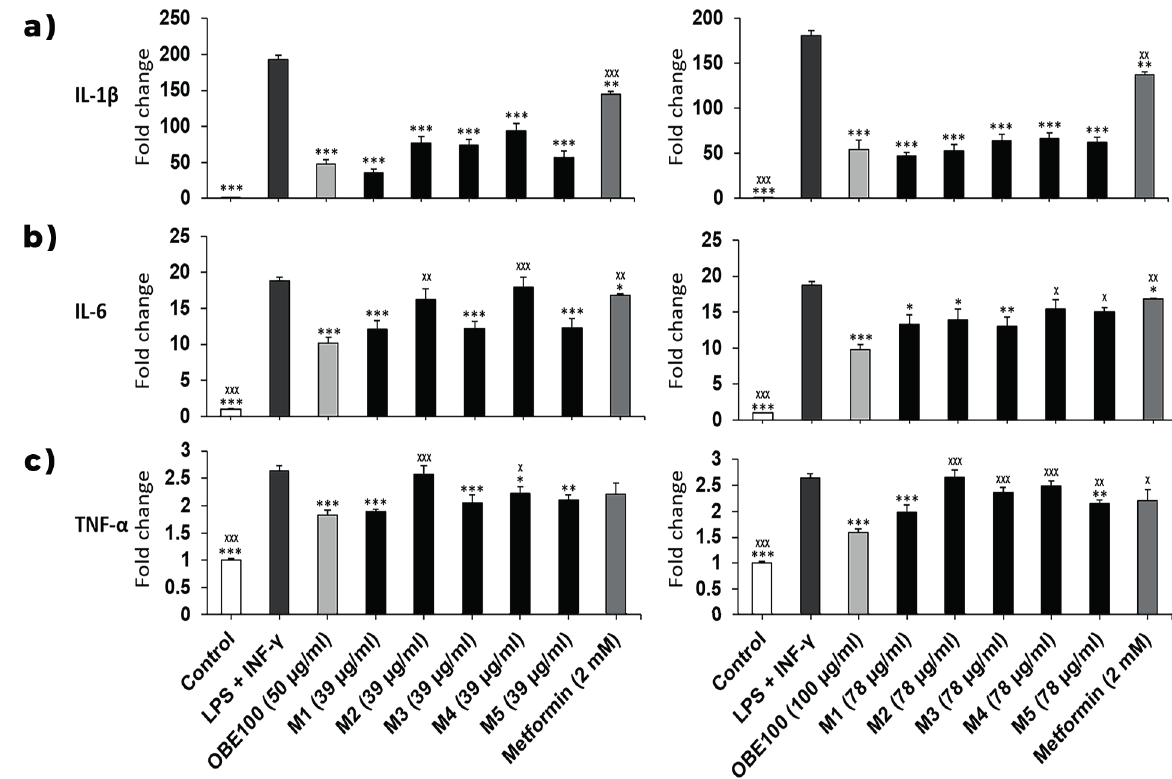
Figure 2. Effect of triterpenoid mixtures on the expression of pro-infl ammatory genes in activated J774A.1 macrophages. Relative expression of (a) IL-1β, (b) IL-6 and (c) TNF-α mRNA transcripts is shown. Values are expressed as mean ± SEM of three independent experiments, normalized to the cyclophilin β gene expression. Metformin was used as positive control.* < 0.05 vs LPS+INF-γ (activated cells), **< 0.01 vs LPS+INF-γ (activated cells), ***< 0.001 vs LPS+INF-γ (activated cells), x < 0.05 vs OBE100, xx < 0.01 vs OBE100, xxx < 0.001 vs OBE100 (ANOVA with Dunnett´s post hoc